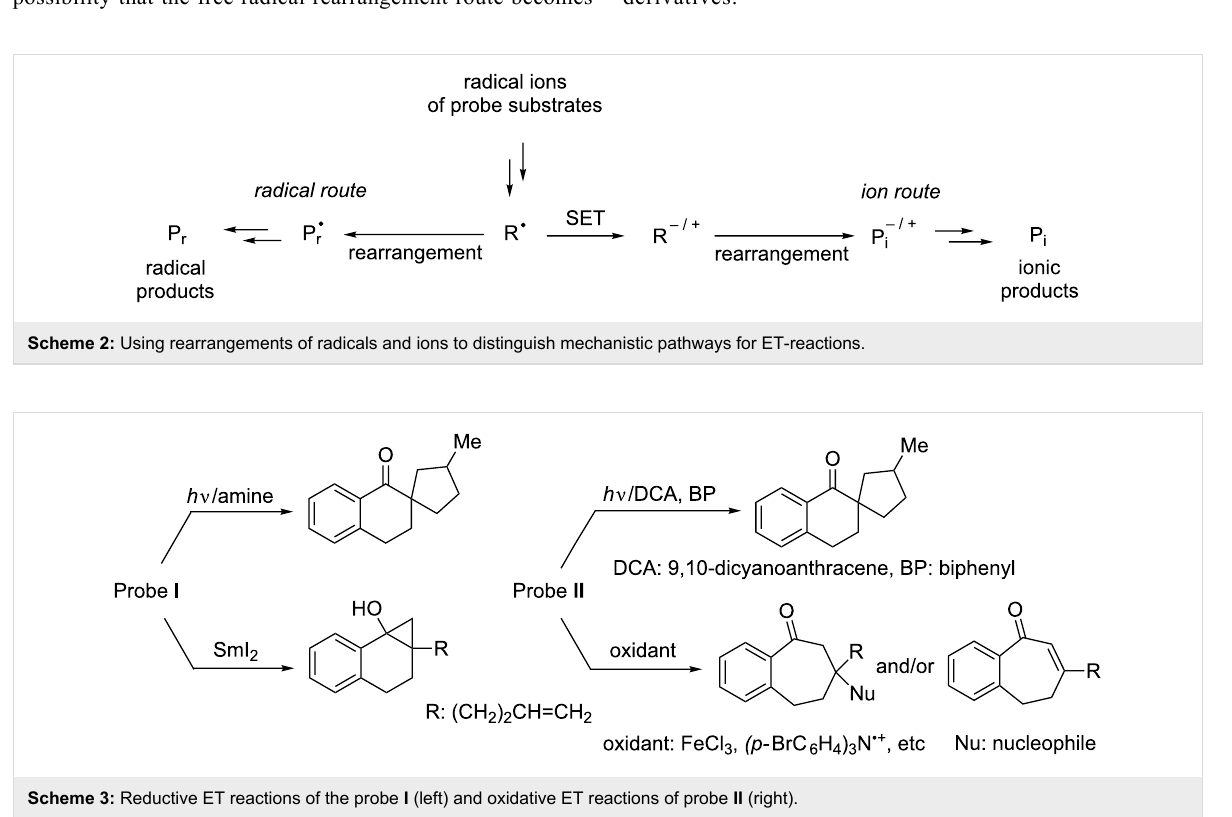
more predominant when oxidizing reagents weaker than Fe(III) are used to promote the reaction. Based on a consideration of the redox potentials of Fe and Cu ions ( E º in H 2 O, V versus NHE), +0.77 for Fe(III)/Fe(II), +0.17 for copper(II)/copper(I) [31], we chose to explore the use of copper(II) reagents in this effort. Although various ET reagents have been employed to promote reactions of cyclopropanol derivatives [32-47], the employment of copper(II) reagents to induce reactions has not been extensively studied [36,39]. In the investigation described below, we have explored copper(II)-salt-promoted oxidative ring-opening reactions of selected bicyclic cyclopropanol